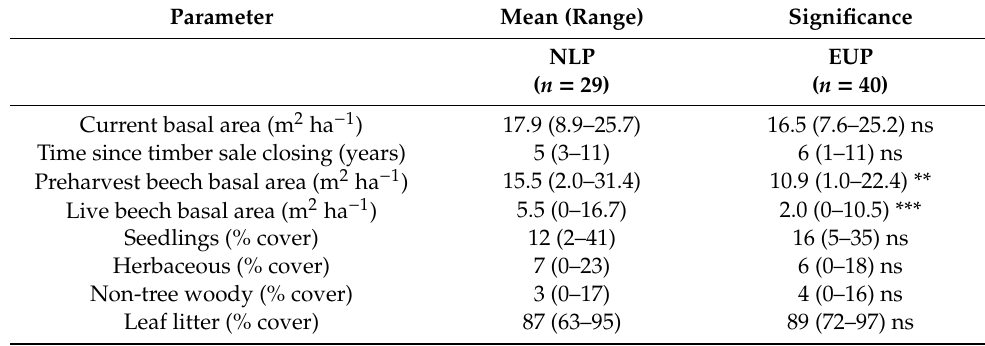
Table 2. Forest stand characteristics: t -tests were used to compare regions (** p < 0.01, *** p < 0.001, ns = not significant). NLP = Northern Lower Peninsula and EUP = Eastern Upper